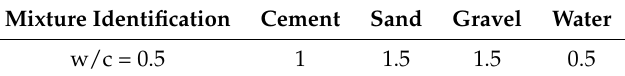
Table 1. Mixture proportions by